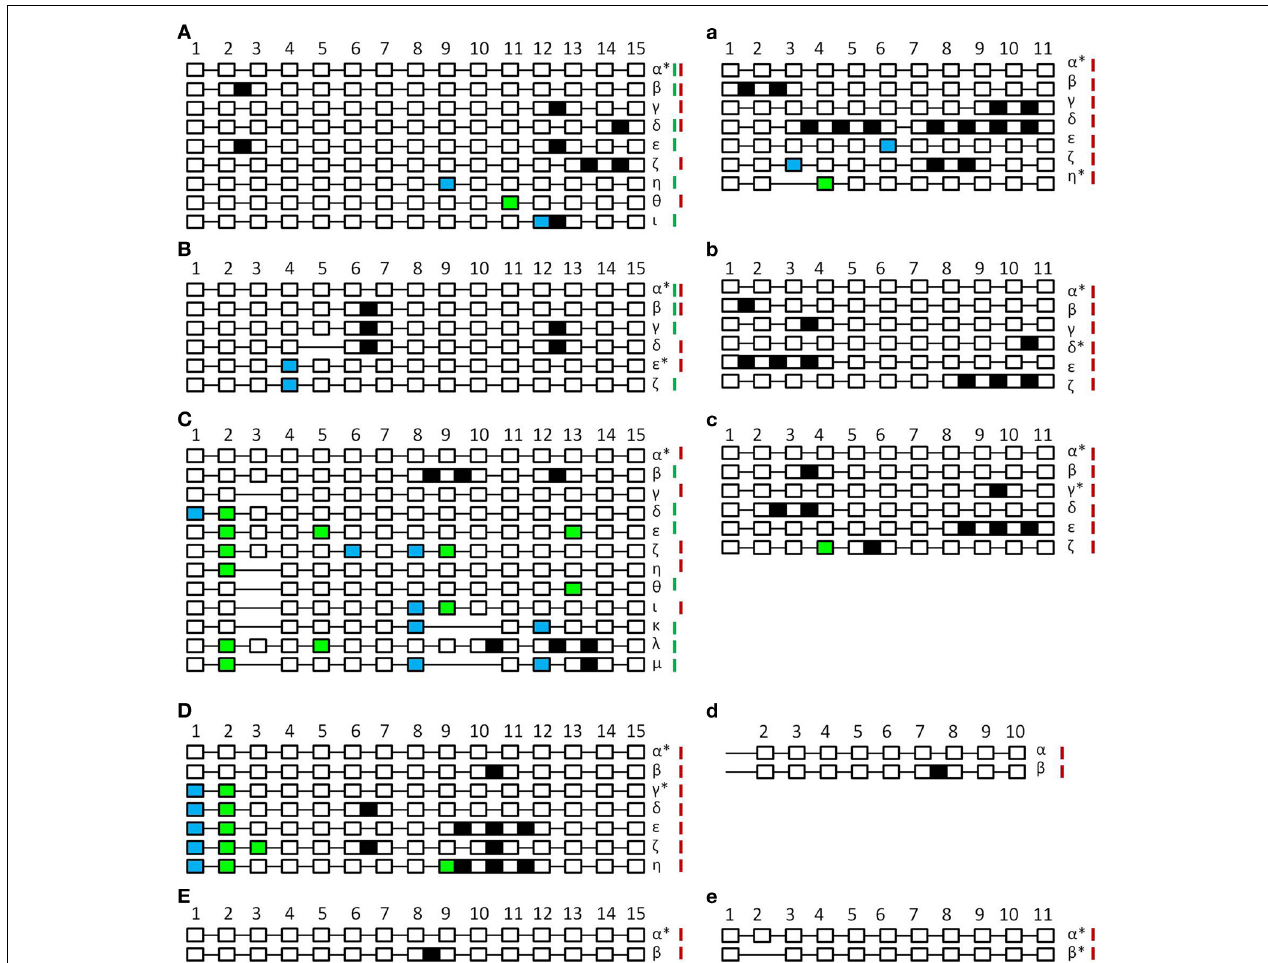
In the case of exon skipping the corresponding white box is missing. Splicing forms are named in Greek letters. Splice forms found in generative tissue are marked with a red bar; splice forms found in vegetative tissue are marked with a green bar. Splice forms found in both tissues have both bars. Putative functional forms are marked with an asterisk. Due to high GC content and resulting PCR failure, amplification of OsaSPO11-2 was only possible from exon 2 so exon 1 is not